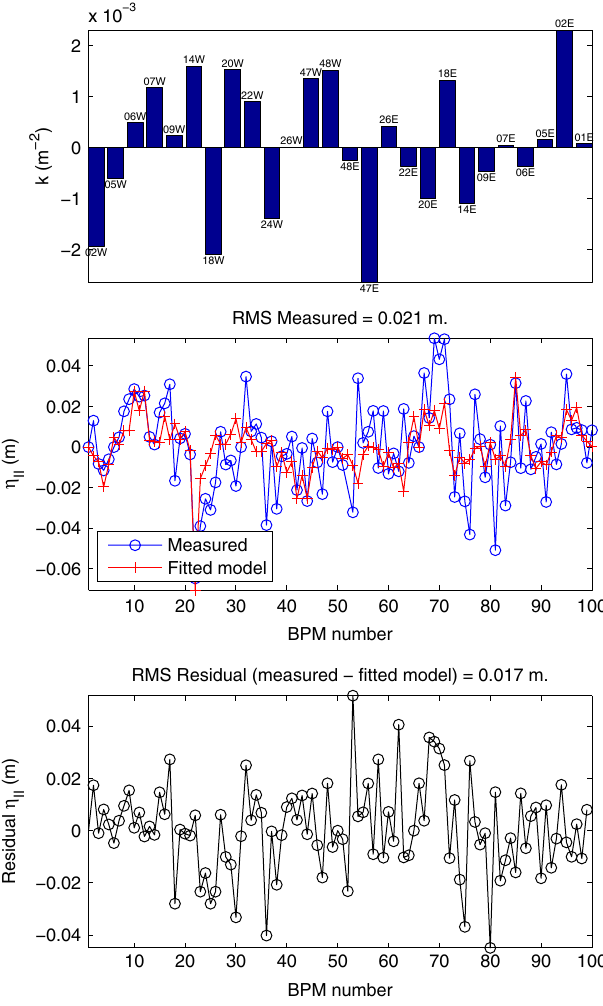
FIG. 10. Measured mode II dispersion after correction of orbit, (vertical) dispersion, and coupling. The middle plot shows a comparison between the measured dispersion, and the dispersion in a model with skew quadrupole strengths adjusted to fit the measurement. The final skew quadrupole strengths found from the fitting are shown in the top plot (the order of the quadrupoles is the same as shown in Fig. 2); the bottom plot shows the residual between the measurement and the fitted model. The rms is the root mean square over the measurements at the BPMs.